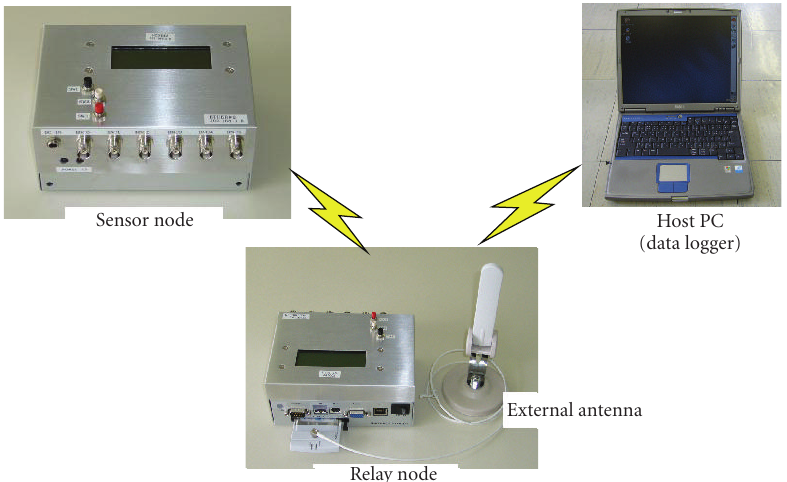
Figure 9: Basic components of the developed vibration measurement system.